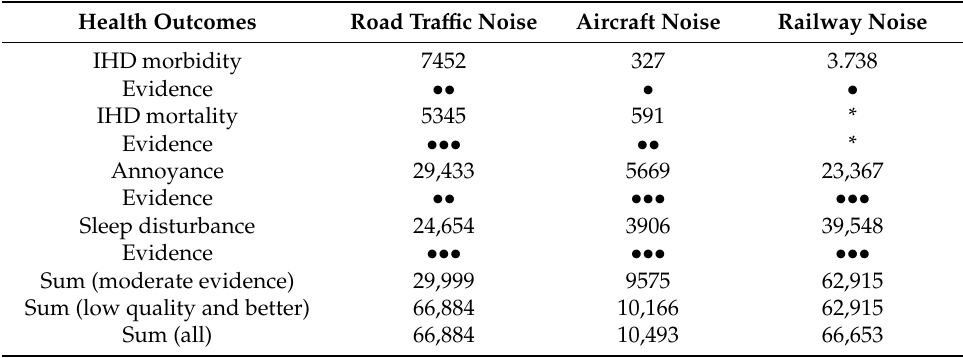
Table 9. Sum of the DALYs attributable to tra ffi c noise by evidence quality.